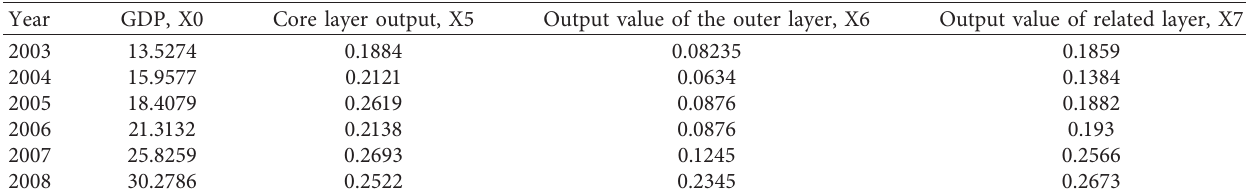
Table 3: GDP and output value of core layer, outer layer, and related layer of cultural industry.